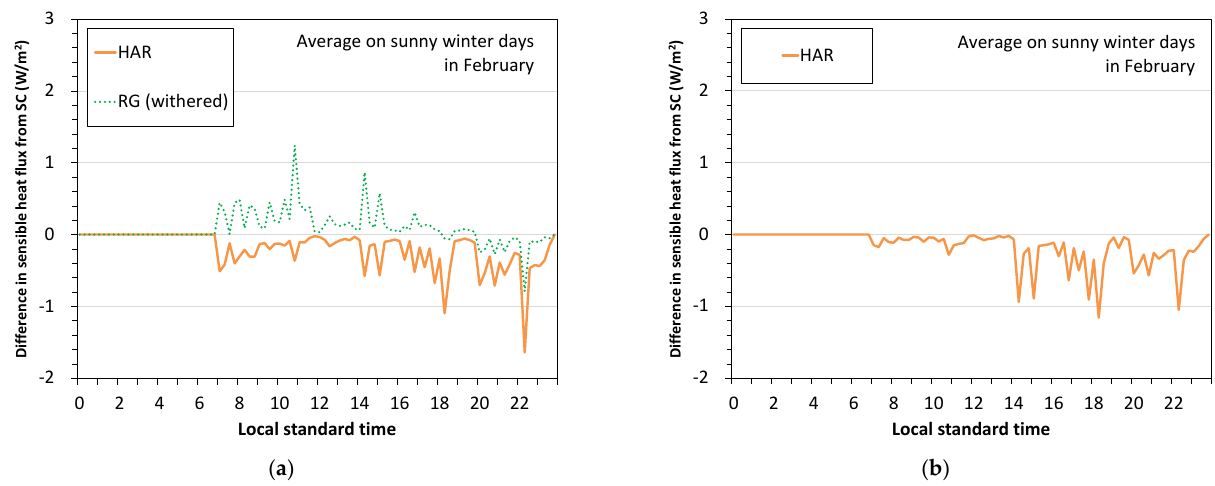
Figure 9. Time series of the difference in sensible heat release from the space conditioning in the case with or without utilizing countermeasures (with-without), on an average value of sunny days in February, for ( a ) reinforced concrete and ( b ) wooden structure with low insulation level.